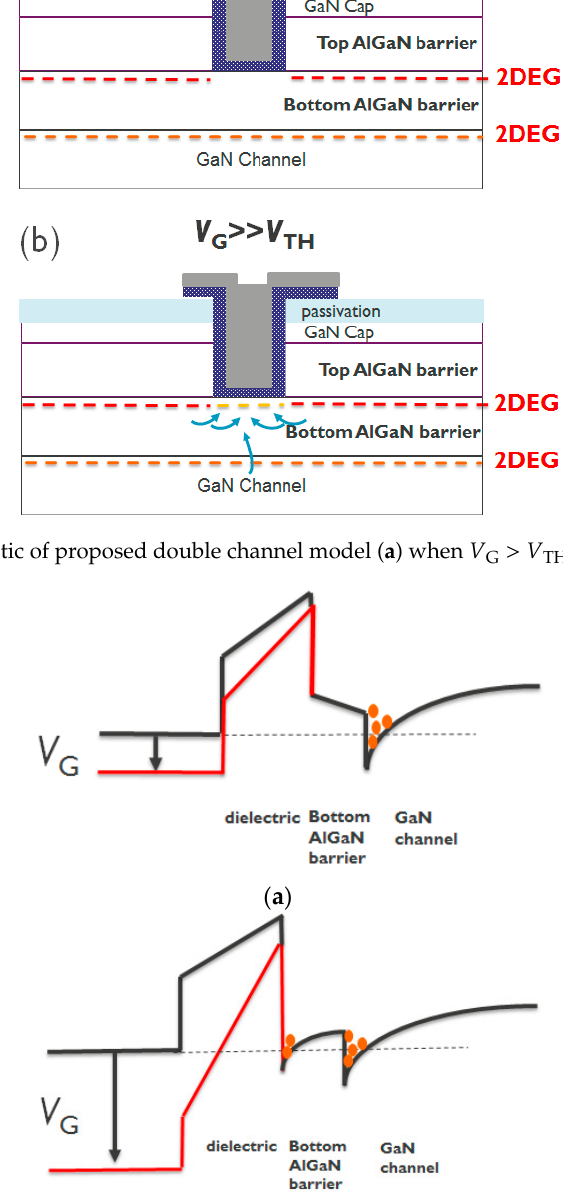
Figure 7. Schematic of the band diagram under ( a ) V G > V TH and ( b ) V G >> V TH .